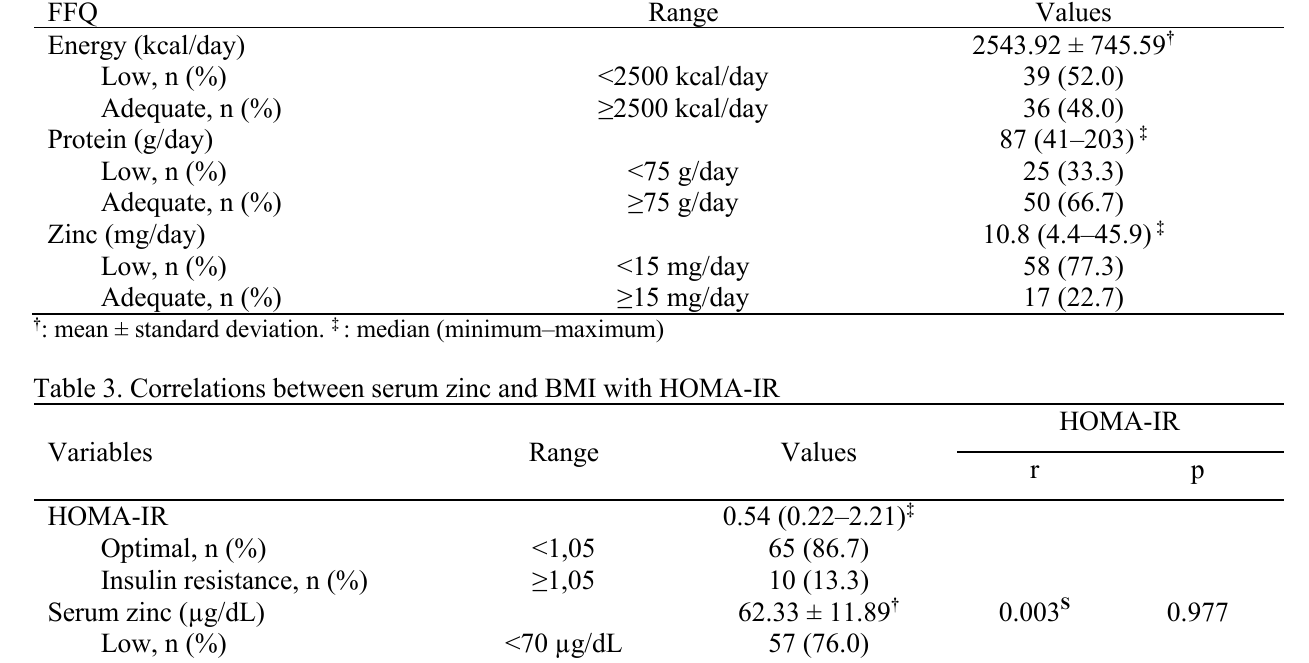
Table 2. Dietary intakes of subjects FFQ Range Values